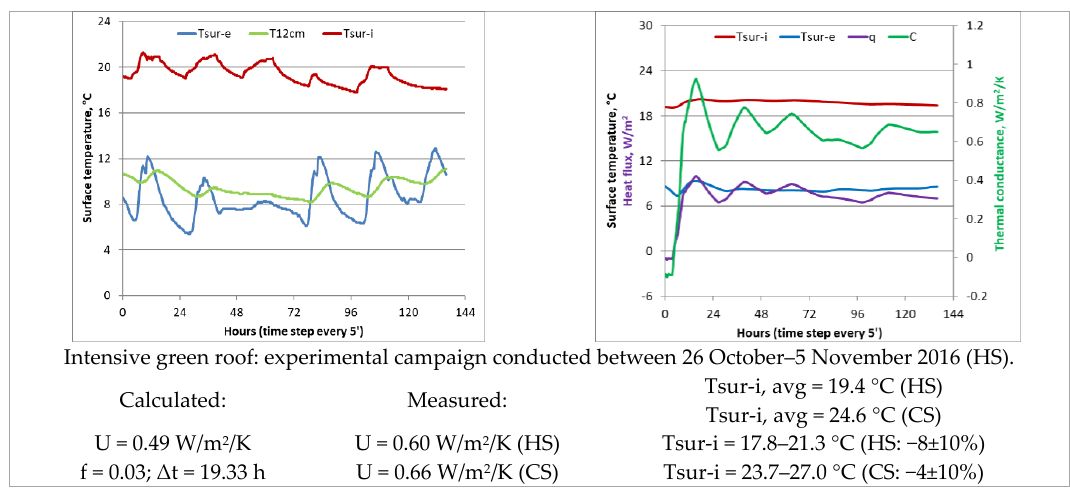
Figure 27. The thermal conductance, transmittance, decrement factor, time shift and internal surface temperature of the thick intensive green roofs.